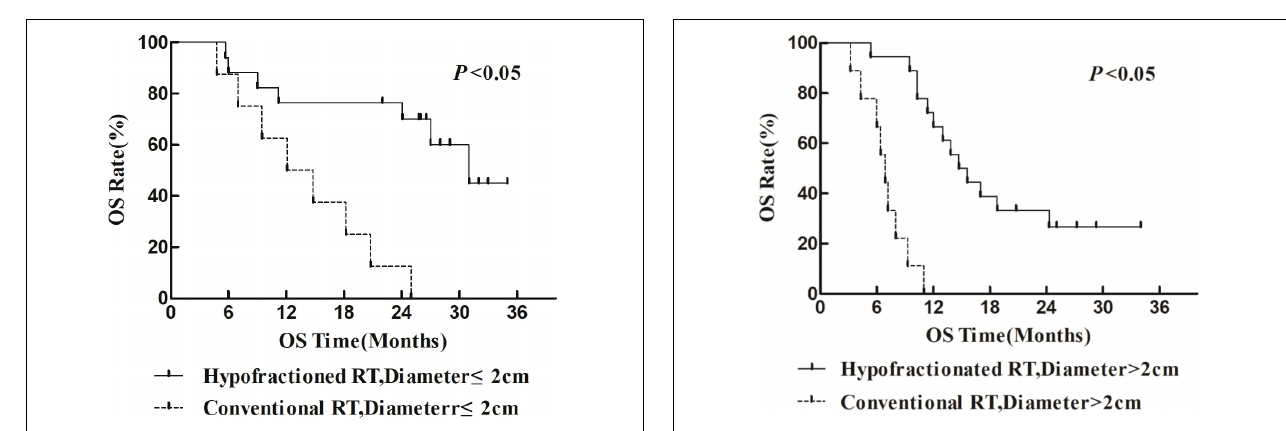
FIGURE 3 | Comparison of OS between HFR group and CFR group in patients with lymph node diameter ≤ 2 cm.